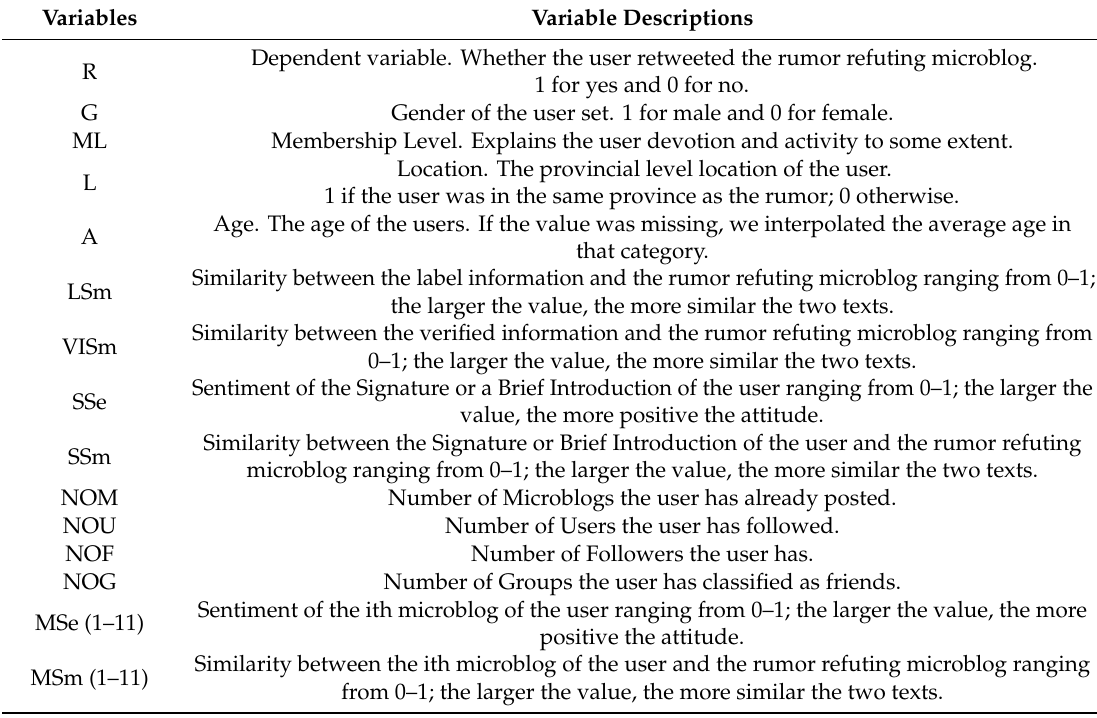
Table 2. Variables for refuter